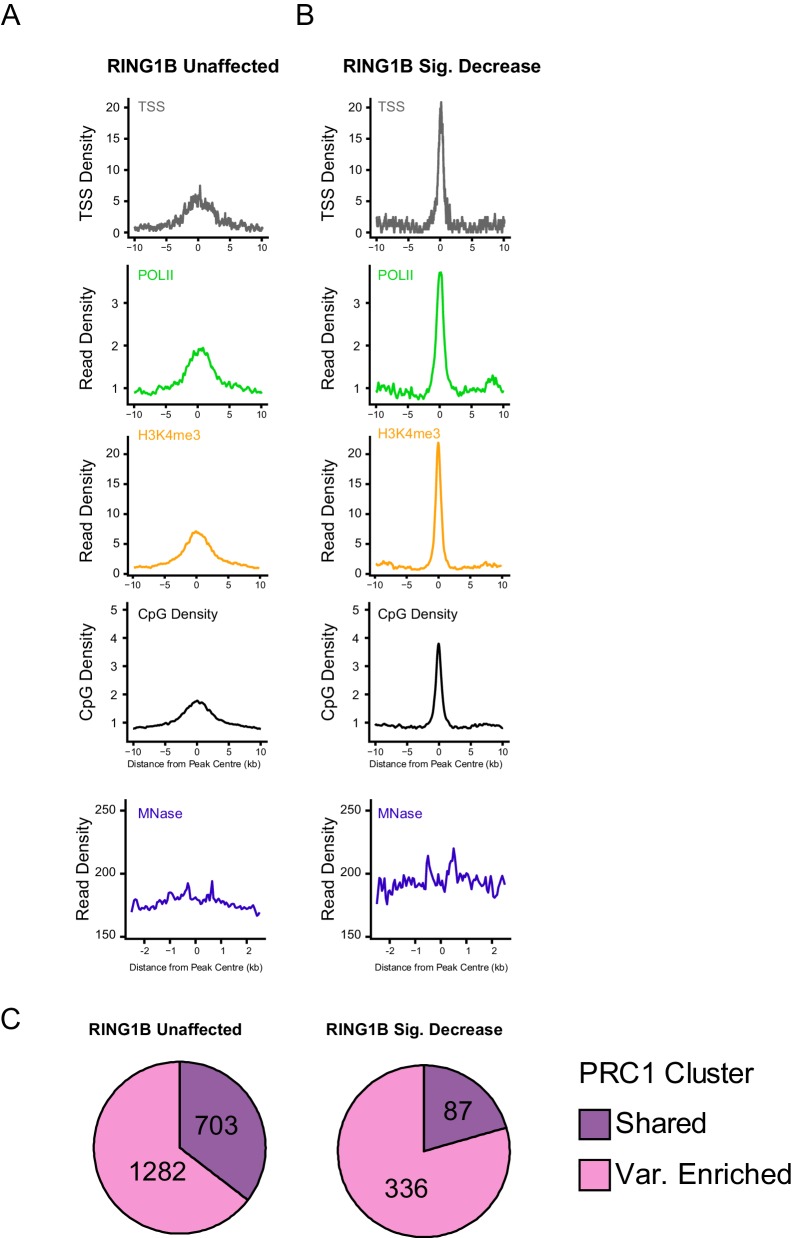
An examination of genomic features at PRC1 targets that retain, or lose, RING1B following deletion of RYBP/YAF2.(A–B) Metaplots illustrating a series of genomic features at H2AK119ub1 peaks with (n = 487) or without (n = 1870) significant reductions in RING1B occupancy in the Rybpfl/fl;Yaf2−/− mouse embryonic stem cells, as depicted in Figure 6. The features profiled include TSS position (TSS), RNA polymerase II (POLII), H3K4me3, CpG density, and nucleosome positioning by MNase-seq. (C) Pie charts indicating whether sites examined in A and B were variant-enriched or shared PRC1 target sites.